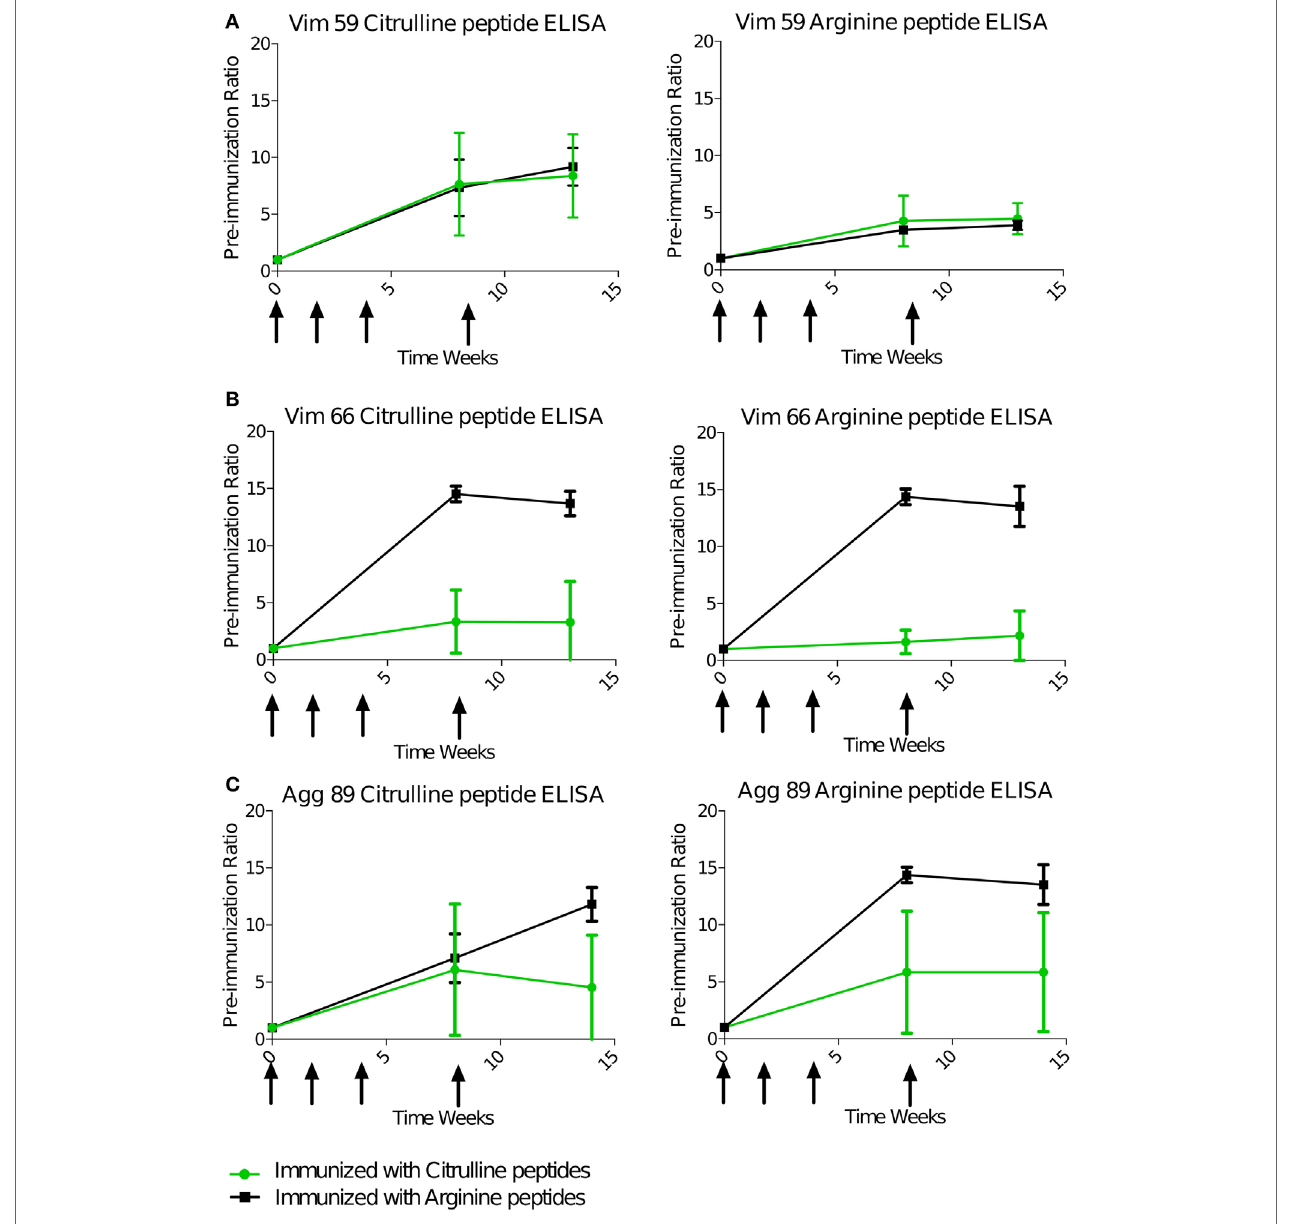
FigUre 2 | B-cell response is cross-reactive to citrulline and arginine. Animals were immunized with pooled citrulline ( n = 4) or arginine ( n = 2), Vim59 and 66, Fg79, and Agg89 peptides at weeks 0, 2, 4, and 8 (arrows). Antibody levels in the serum were assessed by ELISA directed against Vim59 (a) , Vim66 (B) , and Agg89 (c) with cit (left) or arginine (right) except for Fg79 (no response). Data are mean ± SD ratio to the preimmunization state. cit,